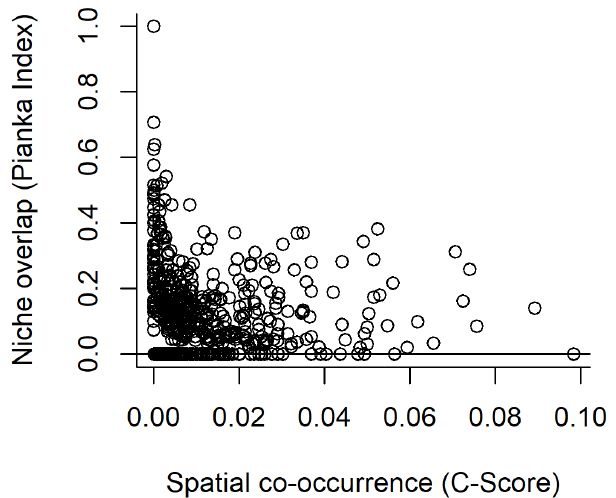
Fig 2. Relationship between niche overlap (Pianka Index) and spatial co-occurrence (C-Score Index), (p = 0.001, r = 0.147) for pairs of ant species sampled in the forest fragment at Catuaba Experimental Farm- UFAC, AC, Brazil.